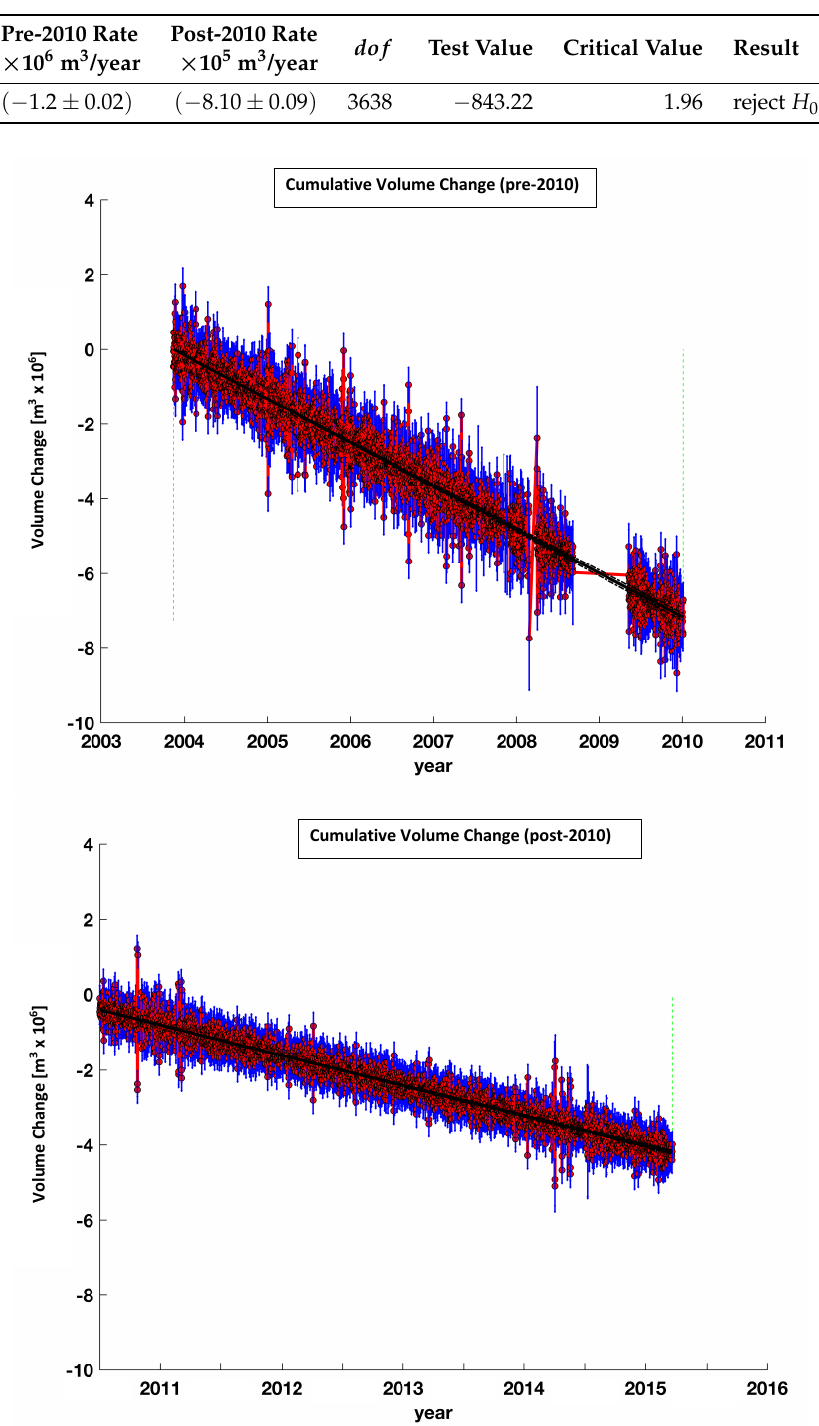
Table 5. Results from two-tailed Student’s t-test with degrees of freedom dof at the 95% confidence level (e.g., [37], p. 524) for volume change rates estimated from GPS data pre-2010 and post-2010. H 0 : no significant difference in rates; H 1 : signficant difference in rates.